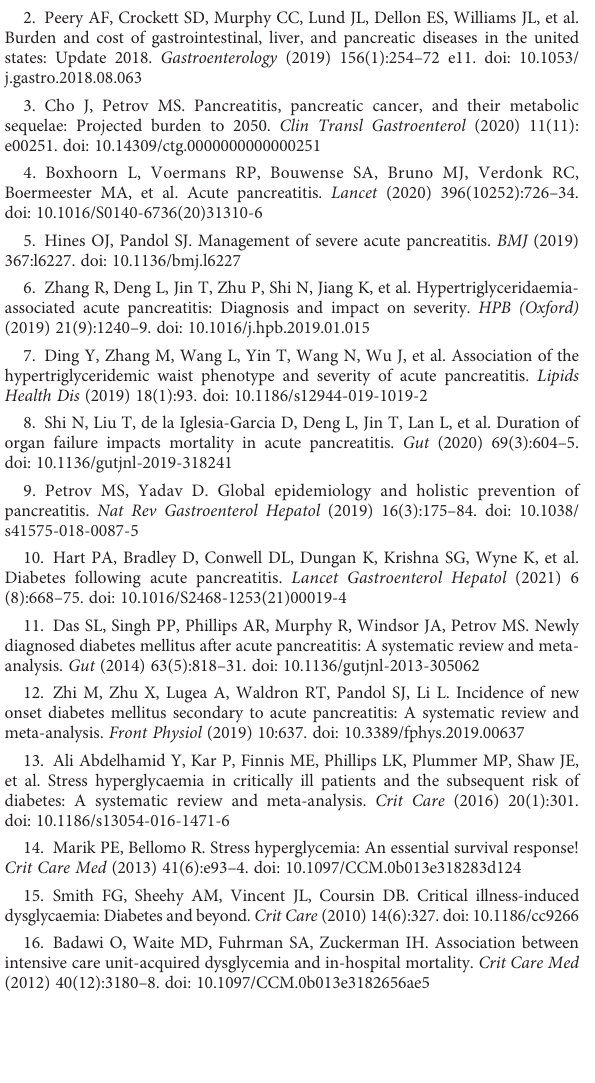
SUPPLEMENTARY FIGURE 3 Glucose and lipid metabolism disorder on admission in AP patients. (A) Correlation between glucose and triglycerides. (B) Admission stress hyperglycaemia in HTG and non-HTG AP patients. TG, triglycerides; MAP, mild acute pancreatitis; MSAP, moderately severe acute pancreatitis; SAP, severe acute pancreatitis; No-SHG, no stress hyperglycaemia; SHG, stress